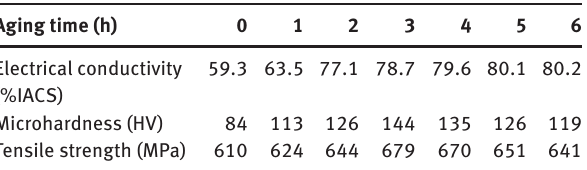
Table 2: Properties of the composite by aging at 400 ° C with 40% cold deformation.